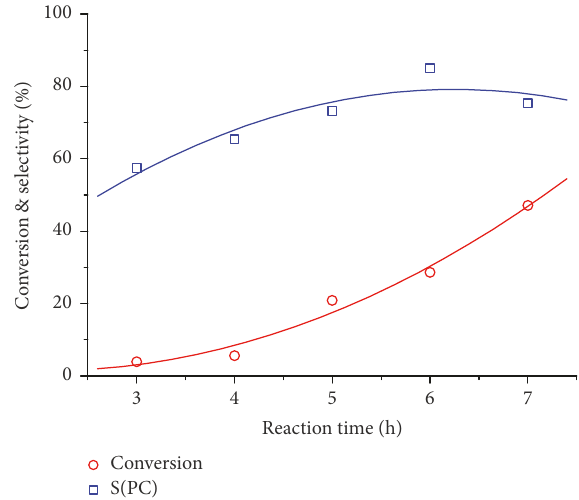
Figure 6: Effect of reaction time on the conversion and PC selectivity. Reactions carried out under 5-bar CO 2 pressure at 65 ∘ C by using 0.150 g of catalyst and 0.050 g of TEABr